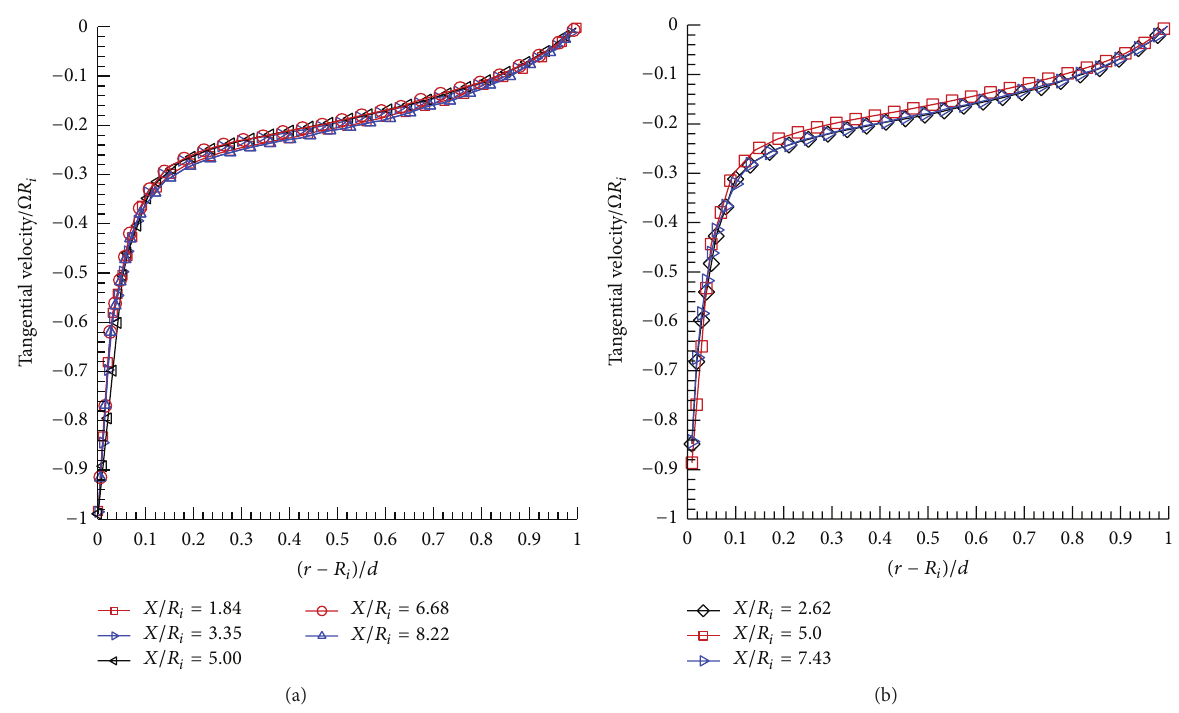
Figure 9: Normalised tangential velocity profiles at the upwell positions on the selected planes at 𝜃 = −𝜋/2 for the test cases (a) Γ = 11.36 and (b) Γ = 7.81